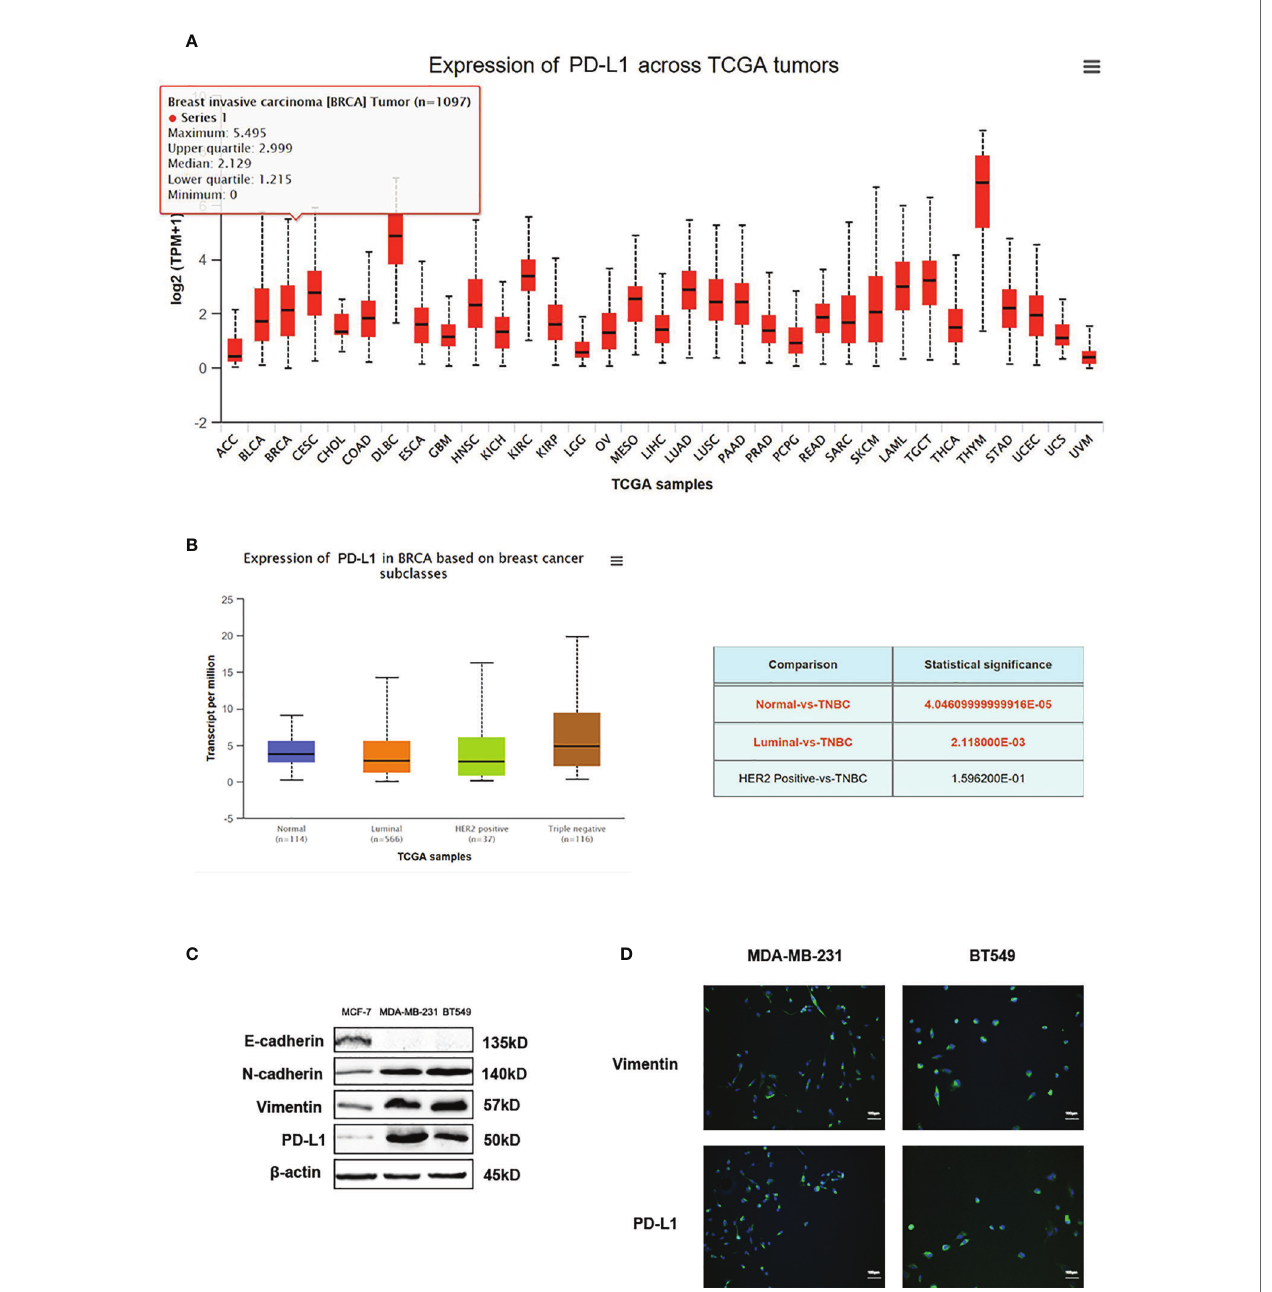
FIGURE 6 | PD-L1 is highly expressed in TNBC. (A) The expression of PD-L1 across TGCA tumors. (B) The expression of PD-L1 in breast cancer subtypes from TGCA database. (C) Western blot analysis of E-cadherin, N-cadherin, Vimentin, and PD-L1 in MDA-MB-231 and BT549 cells. (D) Immuno fl uorescence assay analysis of Vimentin and PD-L1 in MDA-MB-231 and BT549